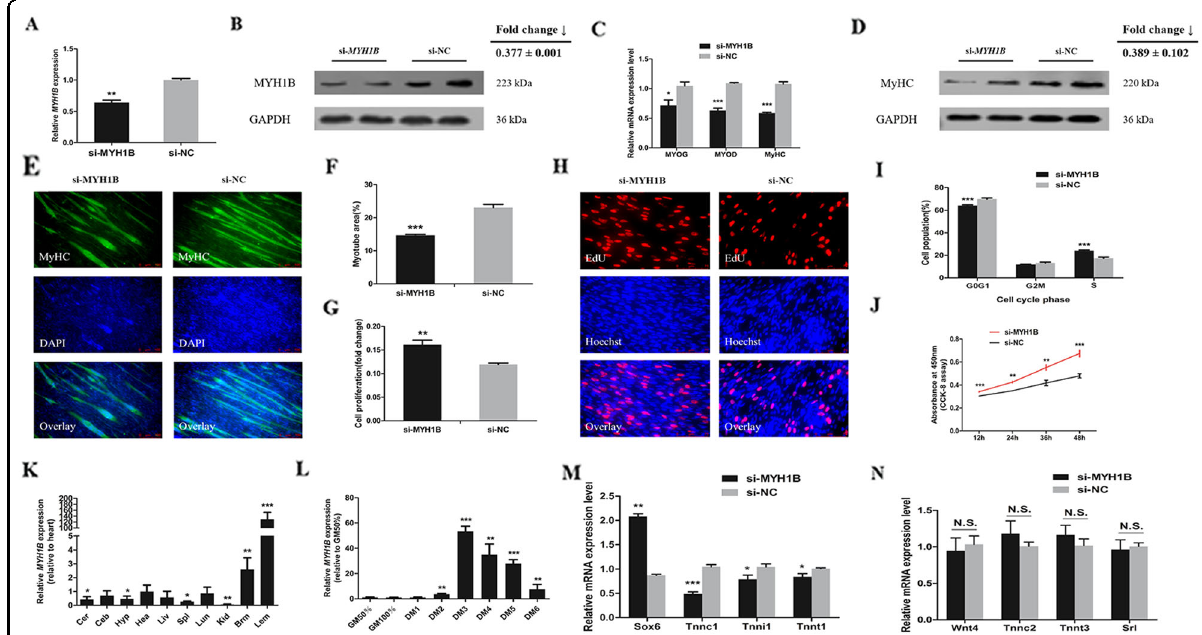
Fig. 6 MYH1B represses cell proliferation, promotes cell differentiation and also induces the slow-twitch muscle phenotype. A The relative expression of MYH1B in CPM cells after transfection with si- MYH1B or si-NC. B The protein expression of MYH1B was determined by Western blotting in CPM cells. C The relative expression of MyoD , MyoG , and MyHC . D The protein expression of MYHC was determined by Western blotting in CPM cells. E MyHC Immuno fl uorescence staining of CPM cells after MYH1B interference. F Myotube area (%) of CPM cells. G The proliferation rate of CPM cells. H EdU proliferation assays for the cells after MYH1B interference. I The results of cell cycle analysis after transfection. J The statistical results of CCK-8 assays. K XH chicken tissue expression pro fi les of MYH1B . L The relative expression of MYH1B during CPM differentiation. M The